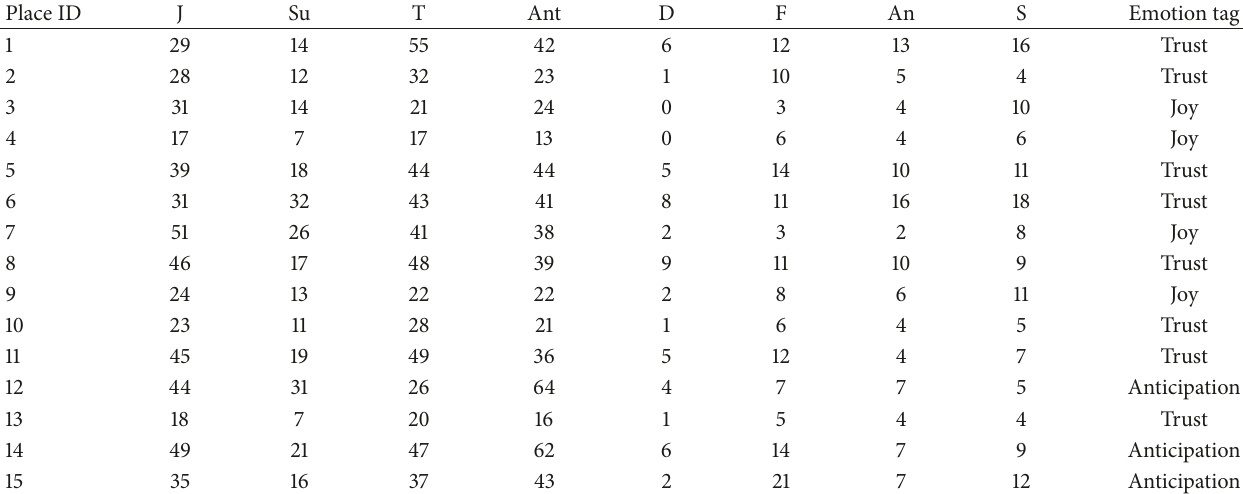
Table 4: Emotion tag derivation of TFs.